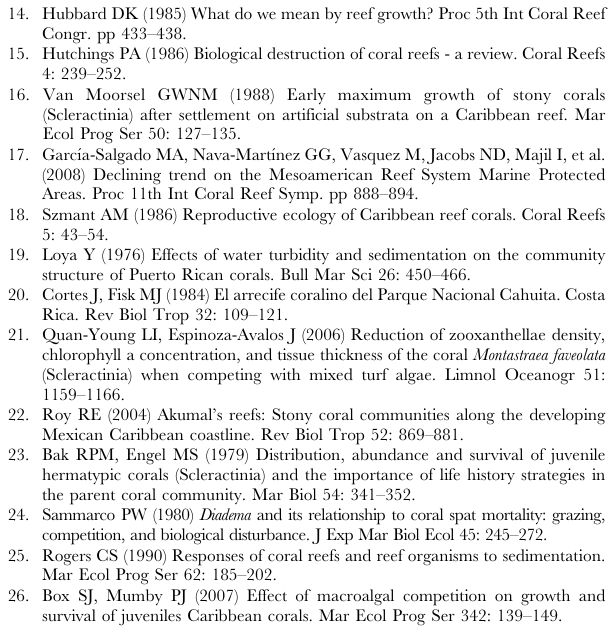
Table S1 Summary of the number of coral species, mean bottom coverage (%) and dominant coral species in terms of the total number of coral colonies sampled in three coral grounds and three coral reefs in the Mexican